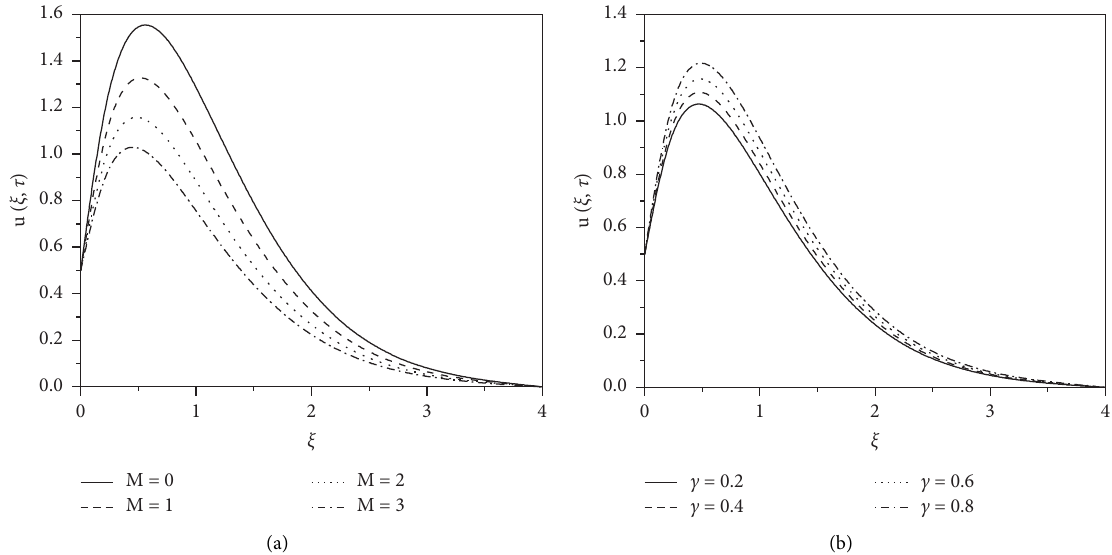
Figure 14: Variation of velocity u ( ξ , τ ) against ξ in the limiting case for various values of (a) M and (b) c . Table 2: Variation of skin friction C f under the various physical parameters.